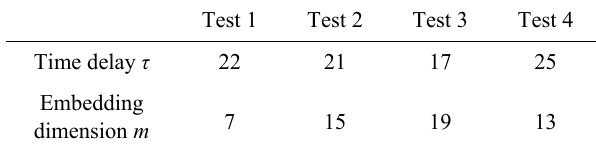
Table 2 Optimal time delay and embedding dimension of friction coefficient in friction process.